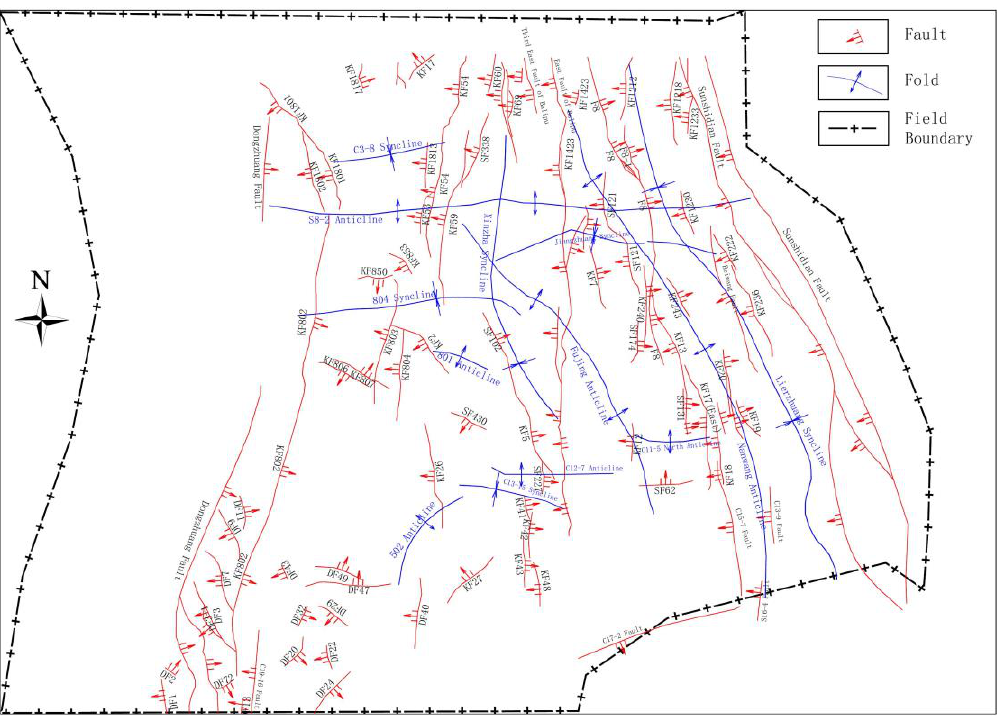
Figure 3. Sketch map of structural geology in Jining No. 3 coal mine.